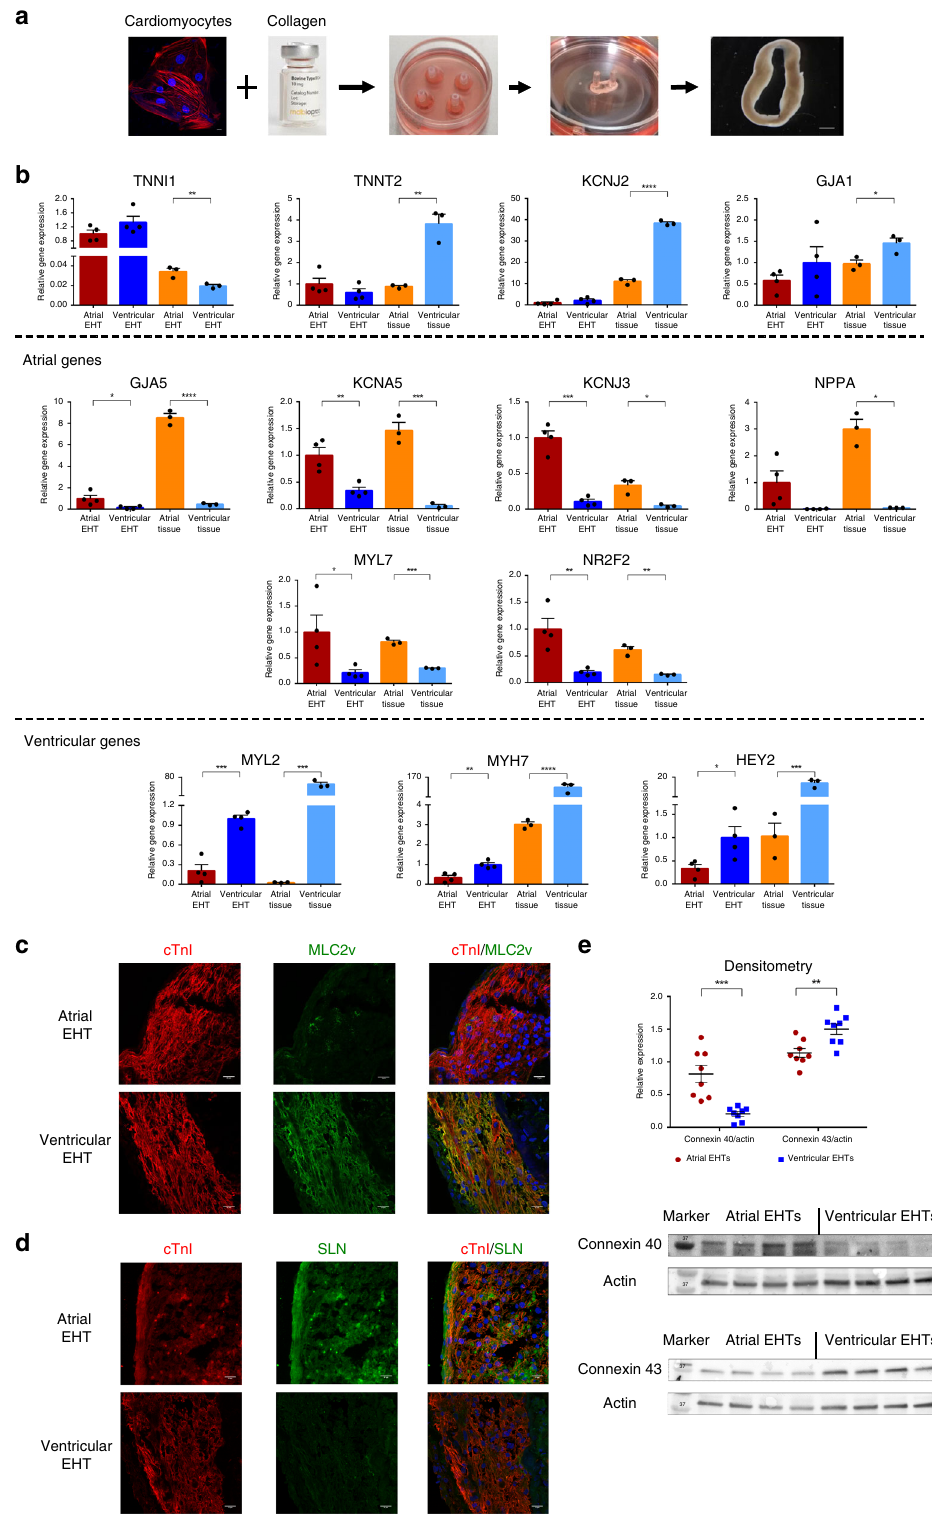
speci fi c marker MLC-2v revealed that the expression of the latter was signi fi cantly enriched in the ventricular-EHTs as compared with atrial tissues (Fig. 2c). Morphometric analysis of the stained specimens, quantifying the relative expression of MLC-2v (calculated as the percentage out the total EHT cellular volume that expresses cTnI that also expresses MLC-2v), revealed that